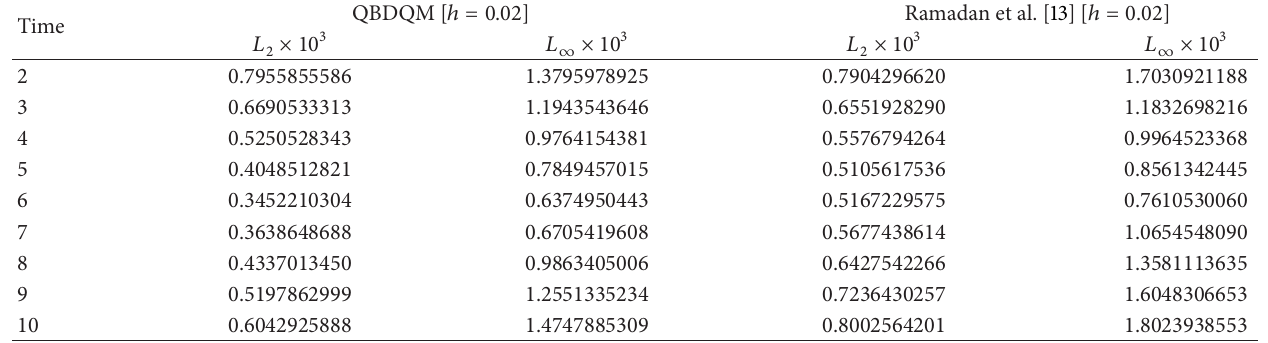
Table 5: 𝐿 2 and 𝐿 ∞ error norms for V = 0.01 , Δ𝑡 = 0.01 , and ℎ = 0.02 .